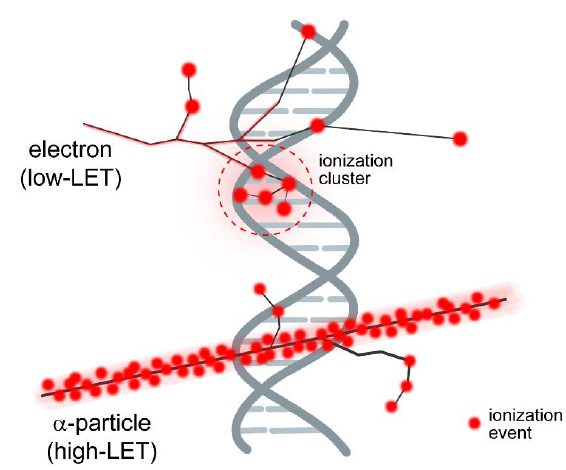
Figure 1. Distribution of ionizations generated in DNA-containing space by electrons of low LET, or high LET alpha particles. Note the increased ionization density from the high LET particle. When ionization events simultaneously break both DNA strands, DSBs are generated. The schematic considers for simplicity only direct IR effects, i.e., ionizations occurring directly on the